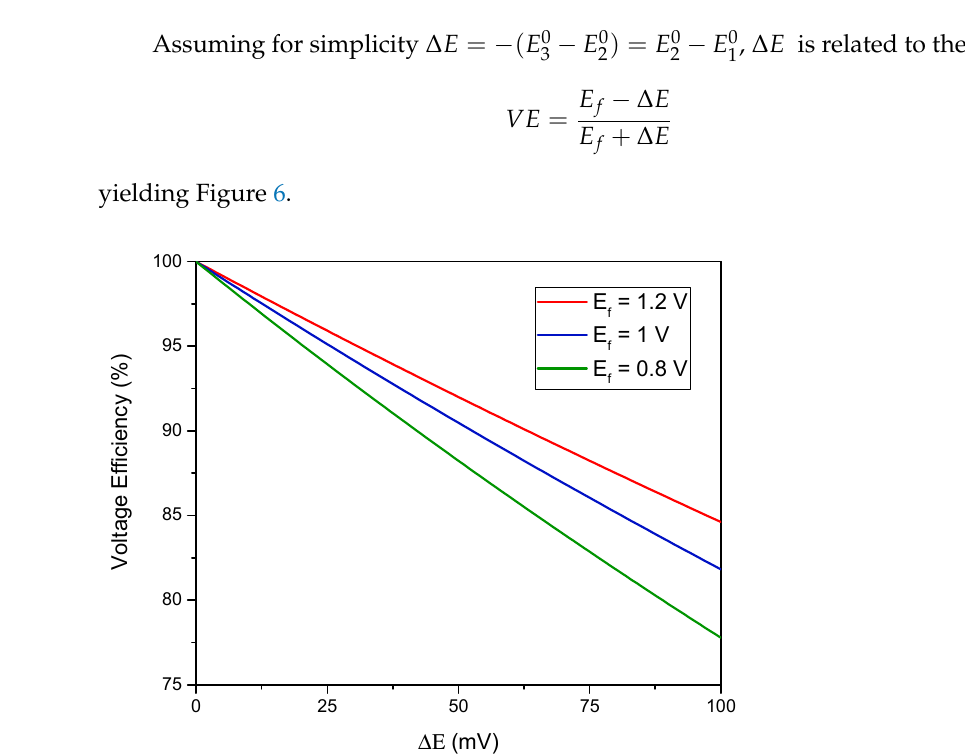
Figure 6. The effect of Δ E on the voltage efficiency.